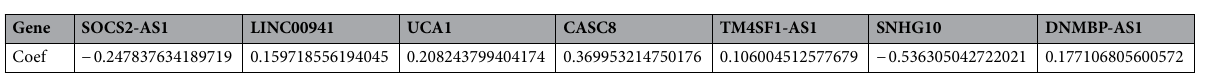
Table 2. Correlation coefficients of model